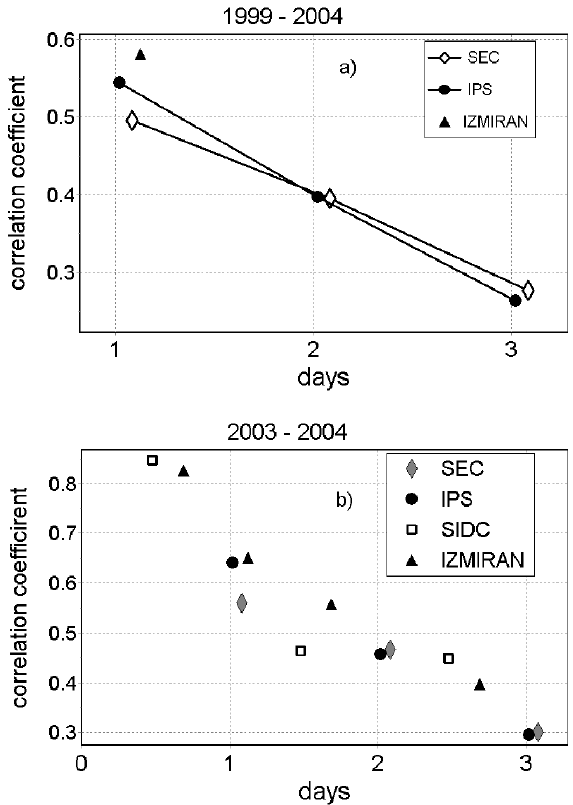
Fig. 1. Correlation coefficients between observed daily A p -indices and these forecasted by different Centers for 1, 2 and 3 days in ad- vance: upper picture (a) presents results averaged within the 1999- 2004 period; lower figure (b) the results averaged over the 2003– 2004